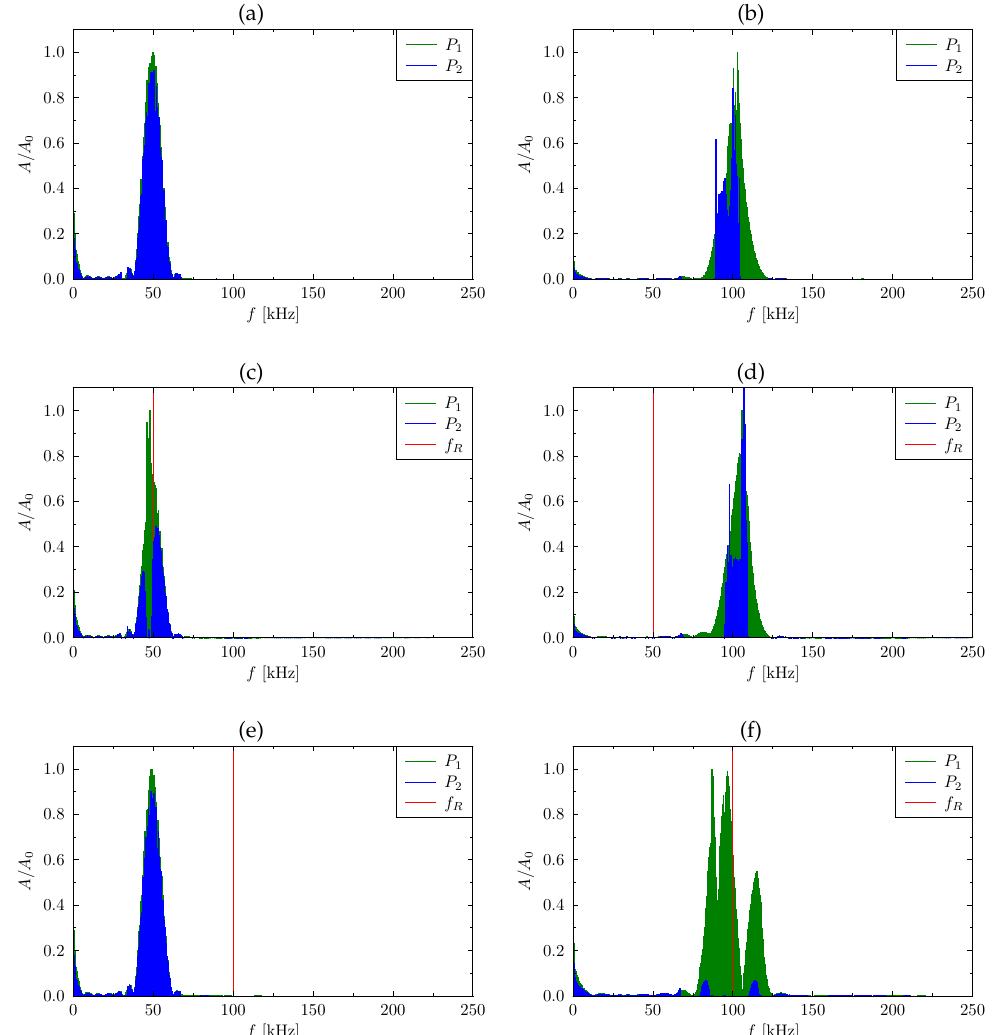
Figure 10. Spectra of flexural oscillations measured before passing through the structure (green) and after passing through the structure (blue). The excitation frequency equal to 50 kHz ( left ) and 100 kHz ( right ) marked with red